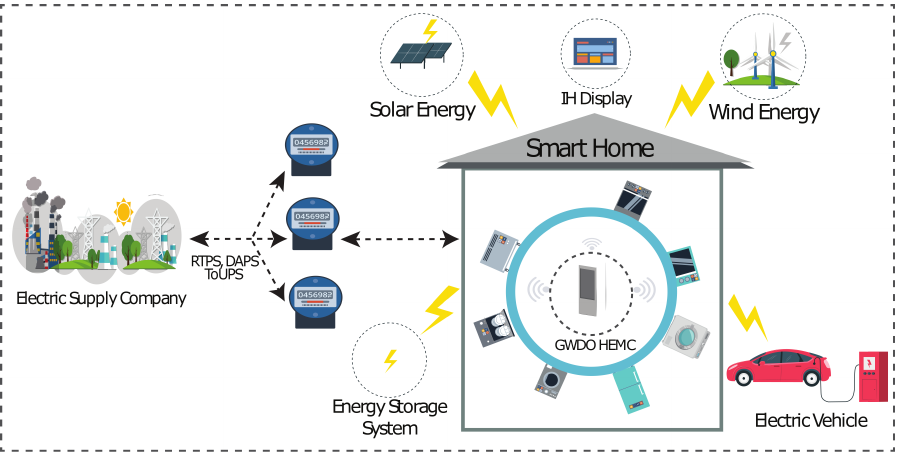
Figure 1. Developed framework for electricity market energy